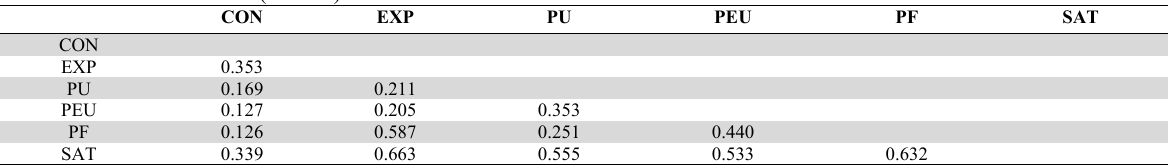
Heterotrait-Monotrait Ratio